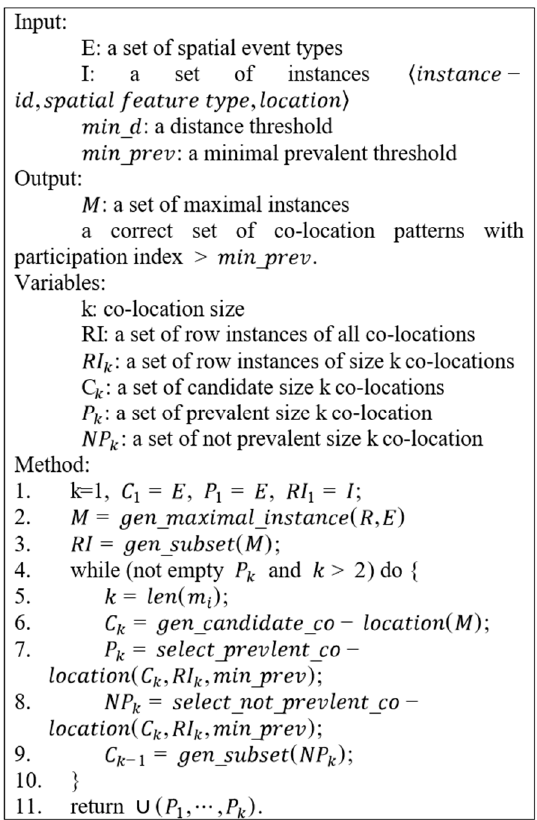
Figure 5. Algorithm for generating co ‐ location patterns.